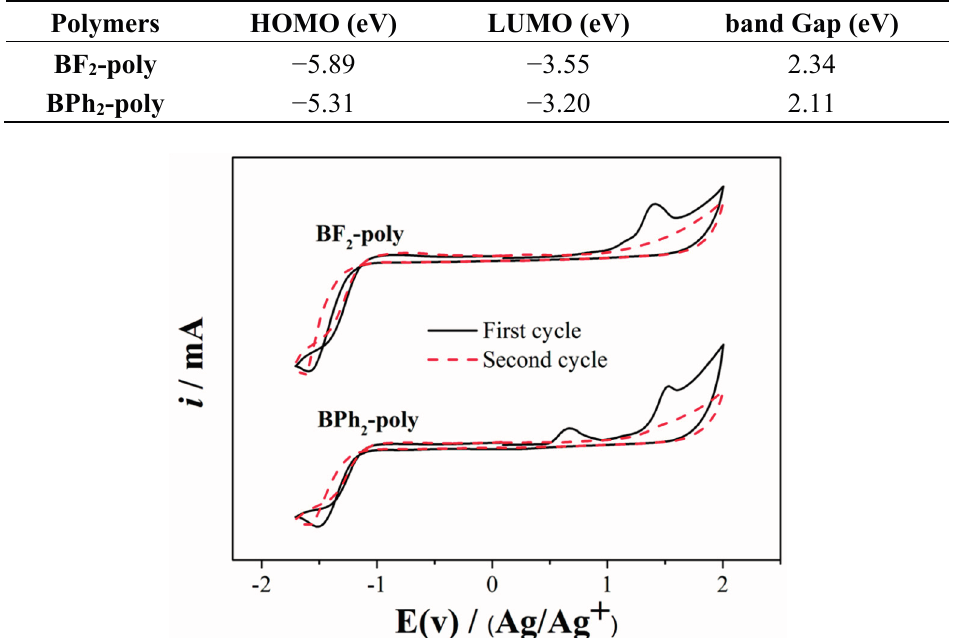
-poly ( b ) in the solid 2